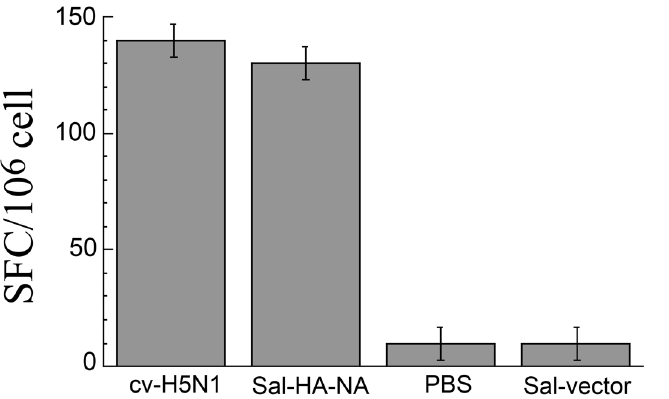
Fig 5. ELISPOT analysis of IFN- γ production by HA 533 – 541 specific T cells in vaccinated mice at 42 days after immunization. Mice were immunized intragastrically at day 0, 14, and 28 with PBS, the commercial H5N1 vaccine (cv-H5N1), and Salmonella SL368 carrying the empty vector pVAX1 (Sal-vector) and constructs p5HA and p5NA (Sal-HA-NA). Splenocytes (n = 5) were harvested from immunized mice at 42 days post immunization and stimulated with HA 533 – 541 peptide for 48 hours. The results were expressed as spot-forming cells (SFC) per million cells. The assays were performed in triplicate and the experiments were repeated three times. The values obtained were the average from these experiments. Statistical analysis was performed by two-way ANOVA. * p < 0 . 01